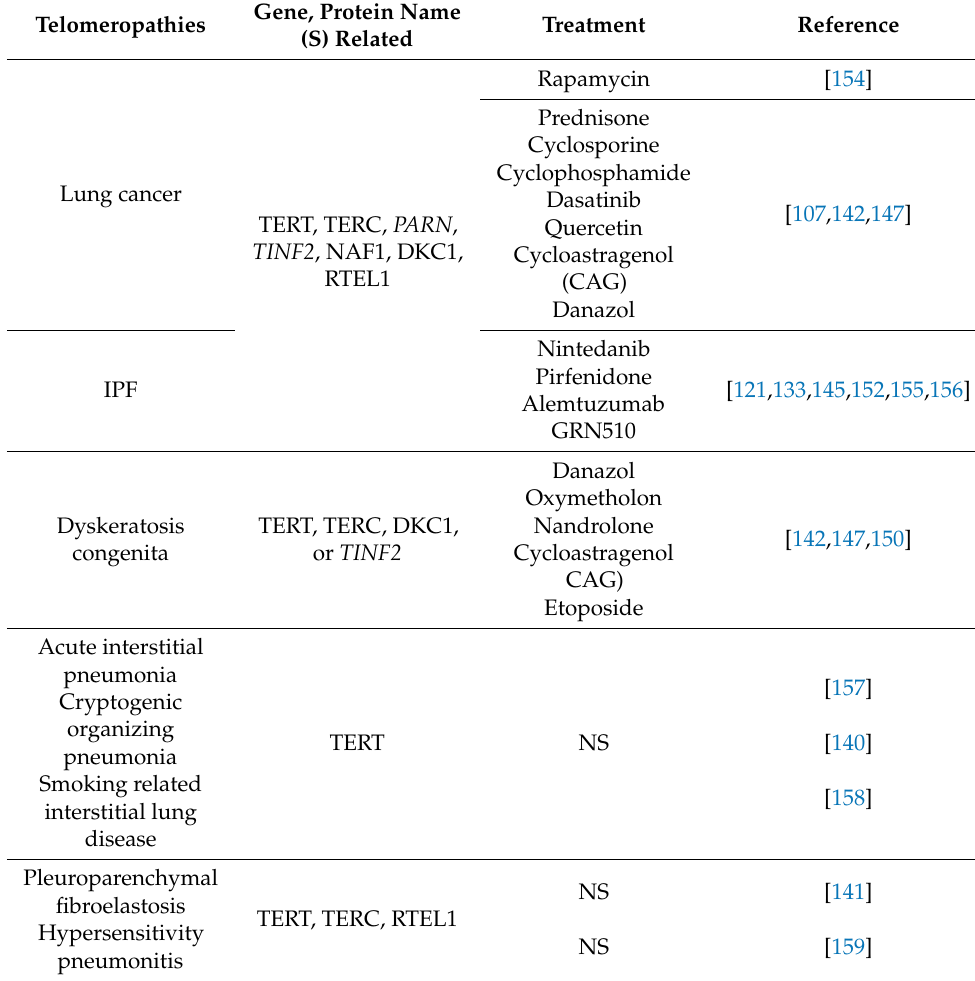
Table 1. Lung diseases associated with shortened telomeres: Related mutations and